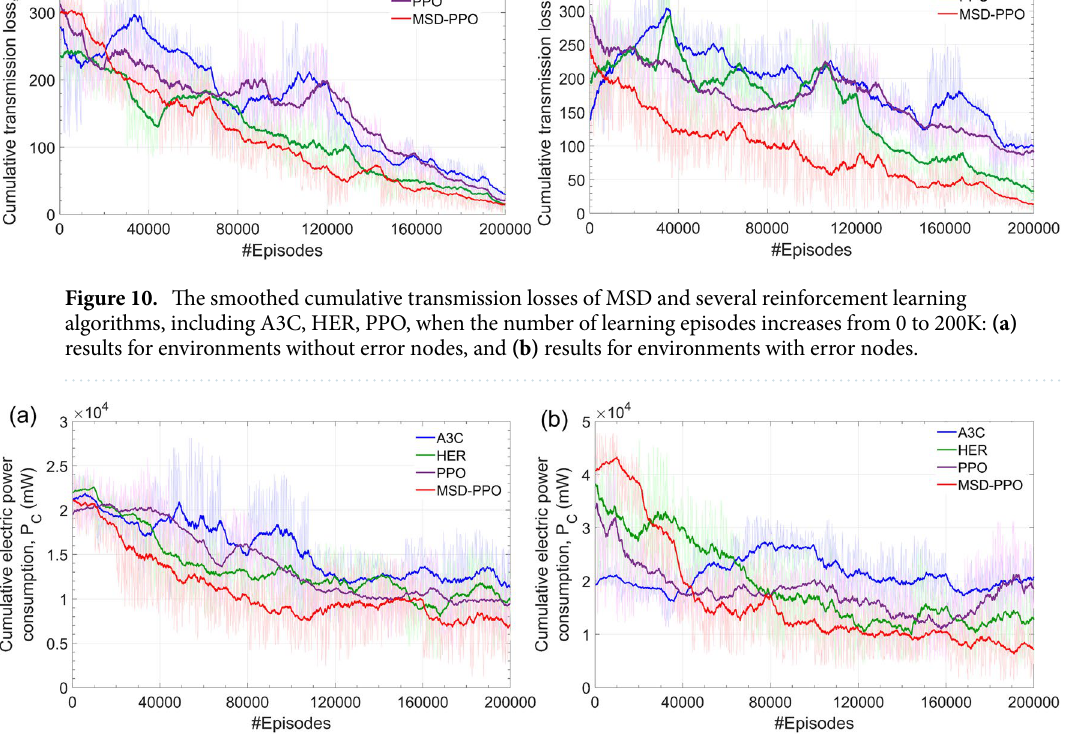
Figure 11. The smoothed cumulative electric power consumption of MSD and several ther reinforcement learning algorithms A3C, HER, PPO when the number of learning episodes increases from 0 to 200K. (a) Results for environments without erroneous nodes. (b) Results for environments with erroneous